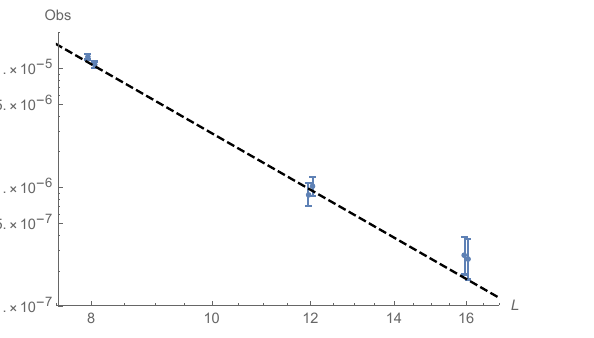
Figure 4 . Determining a con(cid:12)dence interval for (cid:1) I . Left: (cid:1) = 5. Right: (cid:1) = 7.